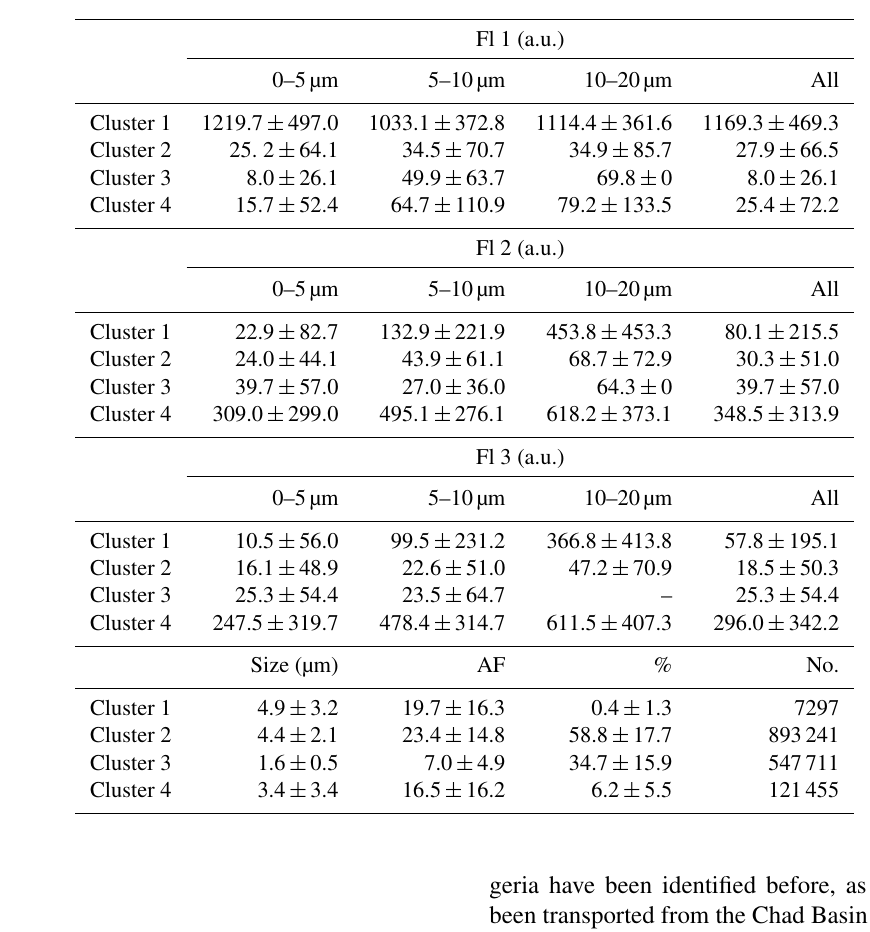
Table 1. Characteristics of individual clusters when using a four-cluster solution for exclusively fluorescent particles ± represents 1 standard deviation, calculated using raw, non-zero particle data. AF represents asymmetry factor as given by the WIBS-4M and % reflects the contri- bution each cluster makes to the total fluorescent particle observations. The “no.” column represents the number of particles classified within a given cluster.